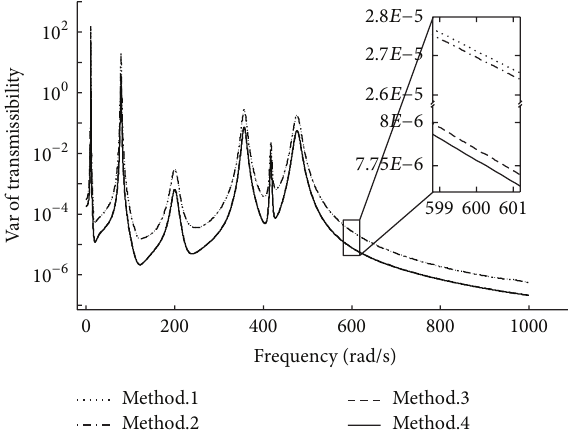
Figure 3: Head-cover transmissibility variances in the frequency domain as predicted by the four